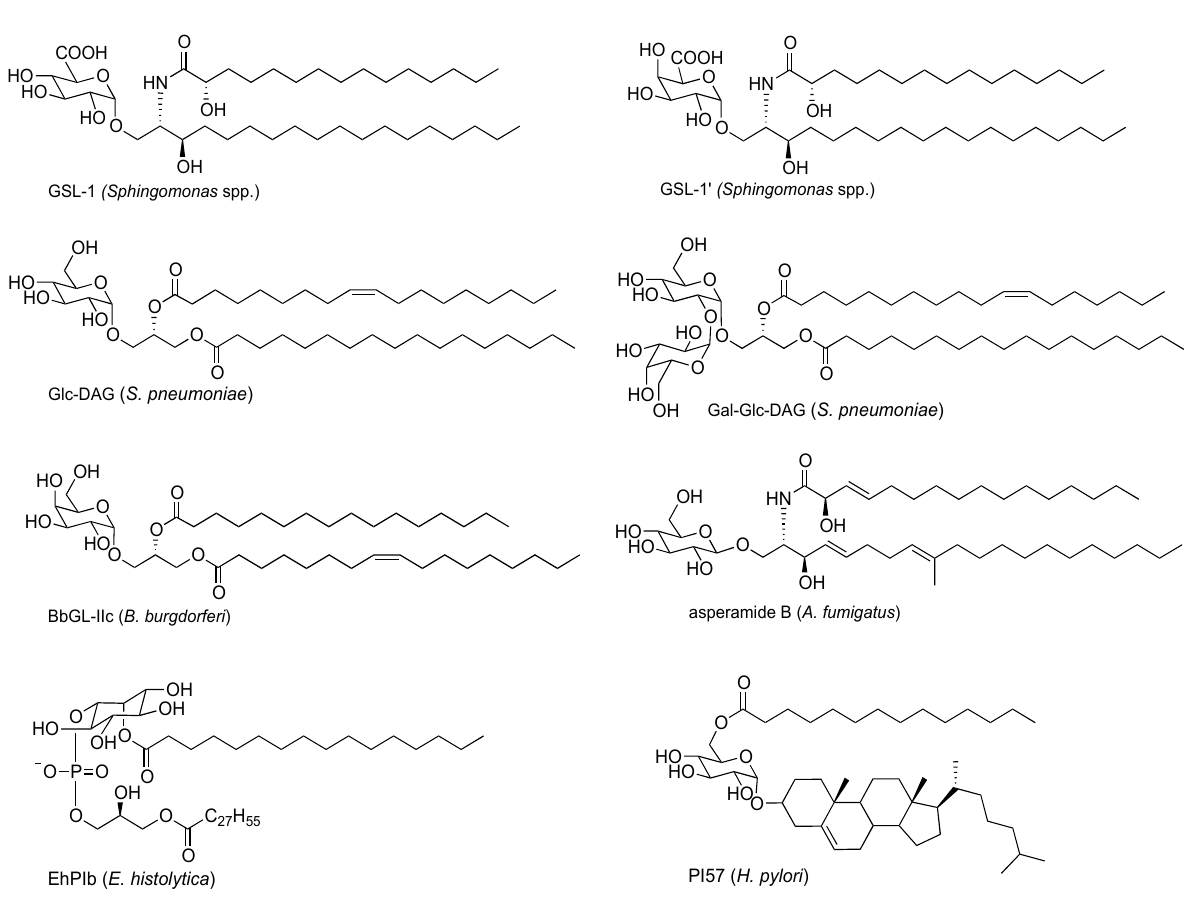
Figure 2. iNKT cell antigens derived from pathogenic